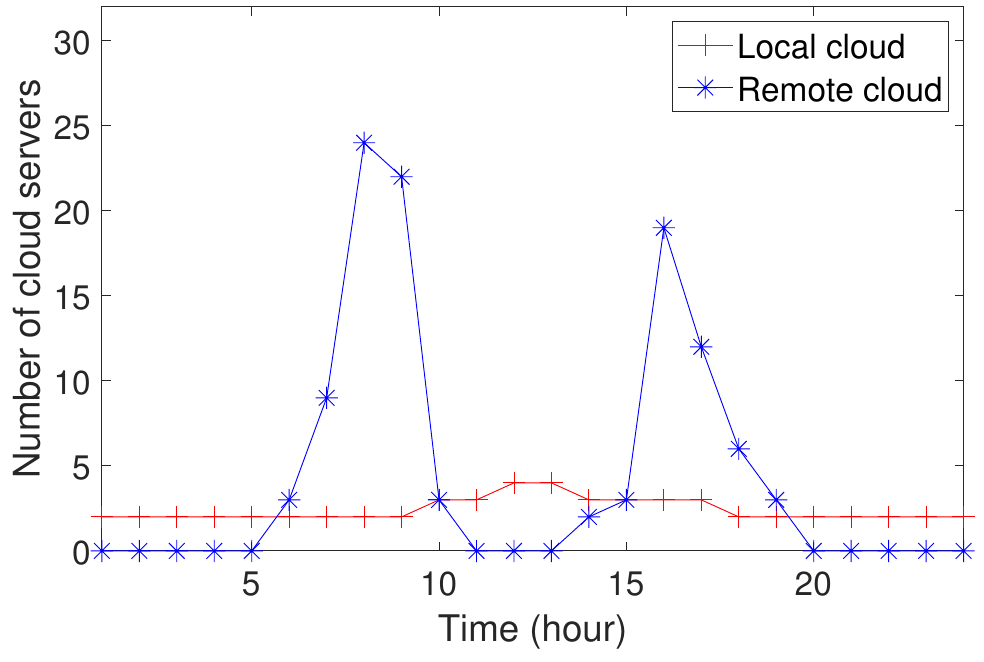
Figure 4. Allocation of both cloud